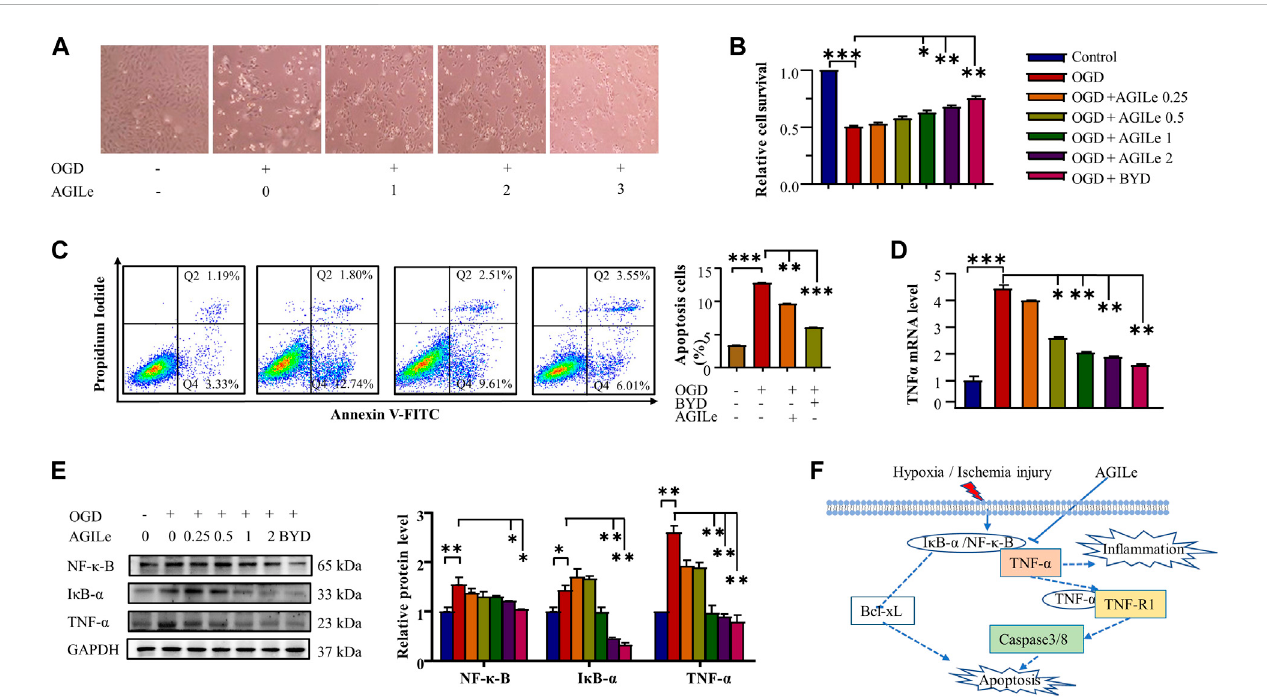
FIGURE 7 In vitro cardioprotective effect of the mixture AGILe. (A) Effect of AGILe on the morphology of H9c2 cells under OGD condition. After AGILe treatment andOGDchallenge,H9c2cells(n=3)wereexaminedunderamicroscope. (B) MTTassayfortheviabilityofH9c2cells.AfterAGILe/BYDEtreatmentandOGD challenge,H9c2cells(n=3)wereincubatedwithMTTandmeasuredonamicroplatereader. (C) FlowcytometricanalysisofapoptoticH9c2cell.AfterAGILe/ BYDEtreatmentandOGDchallenge, H9c2cells(n=3)werestainedwithAnnexinV-FITCanddetectedona fl owcytometer. (D) qRT-PCRquanti fi cation ofTNF- α mRNA.AfterAGILe/BYDEtreatmentandOGDchallenge,TNF- α mRNA(n=3)wasquanti fi edbyqRT-PCRtechnique. (E) WesternblotanalysisofNF- κ B,IkB- α ,andTNF- α .AfterAGILe/BYDEtreatmentandOGDchallenge,H9c2cells(n=3)werelysedandanalyzedbyWesternblottingwithspeci fi cantibodies. (F) Molecular mechanism underlying the cytoprotection of the mixture